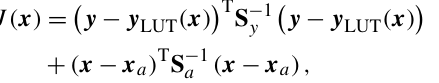
Table 1. Note the log (COT) bounds translate to an absolute 10 COT range of 0.5 to about